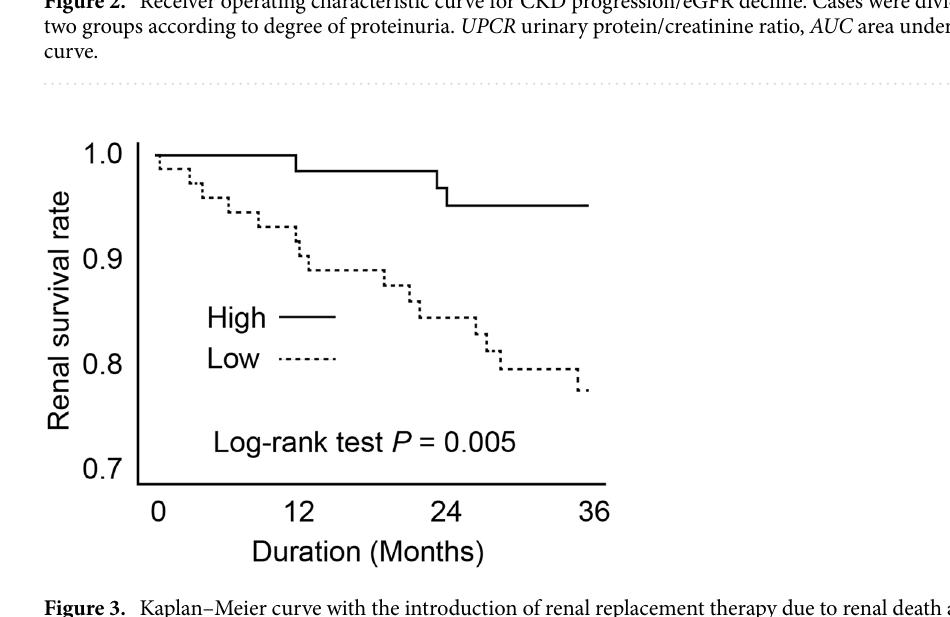
Figure 3. Kaplan–Meier curve with the introduction of renal replacement therapy due to renal death as the endpoint. ‘High’ and ‘Low’ correspond to the magnitude of the gradient of T2* value of the inner and outer layers of the